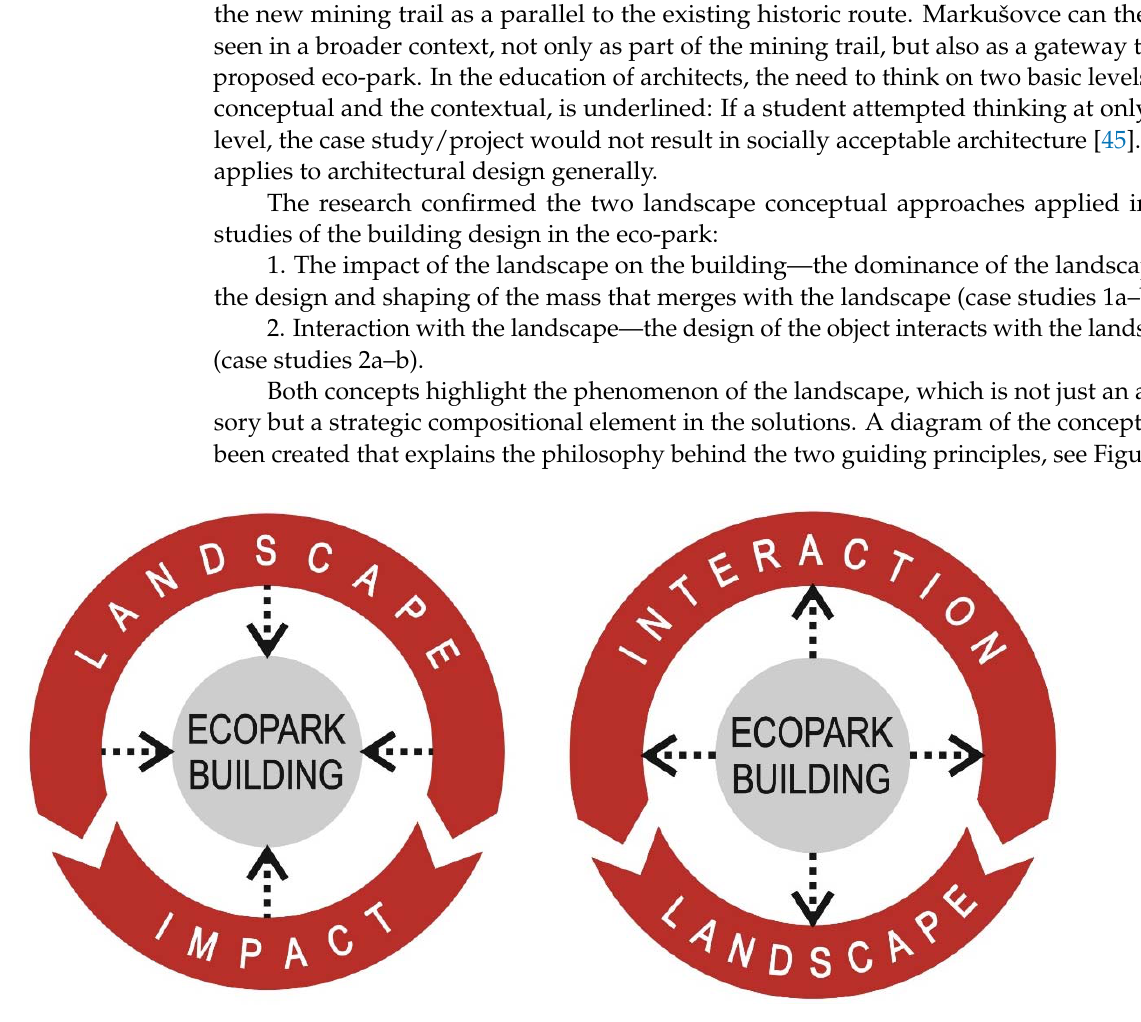
Figure 14. Scheme of two eco-park building design concepts (scheme from the author).